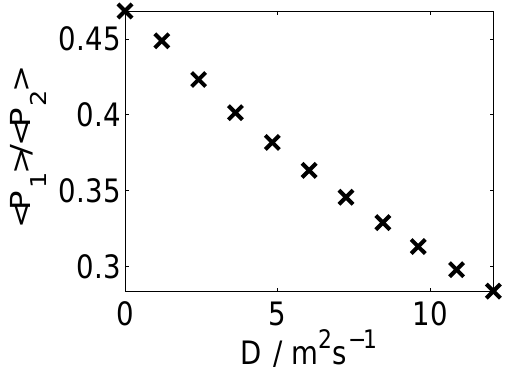
Fig. 18. Ratio of the spatio-temporal average abundance of the two phytoplankton groups versus the vortex strength. circles: D = 10 m , crosses: D = 0 m .